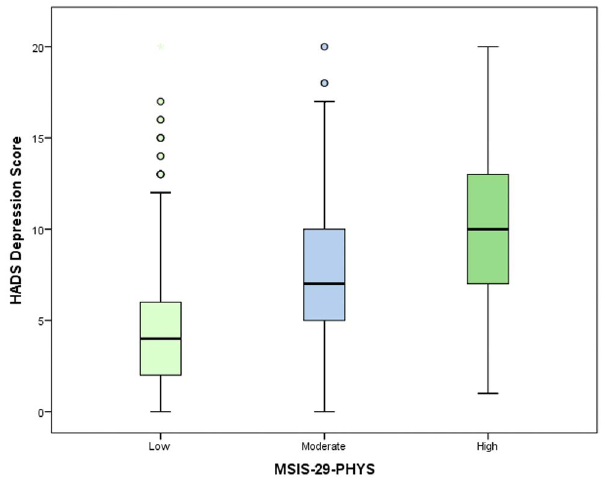
Figure 4. The variation in depression scores by physical disability. This shows the variation in the median (and IQR of the) depression scores in relation to MSIS-29-PHYS scores divided into tertiles and categorised as low, moderate and high disability. The depression scores were highest for people in the high disability category and lowest in the low disability category (p ,